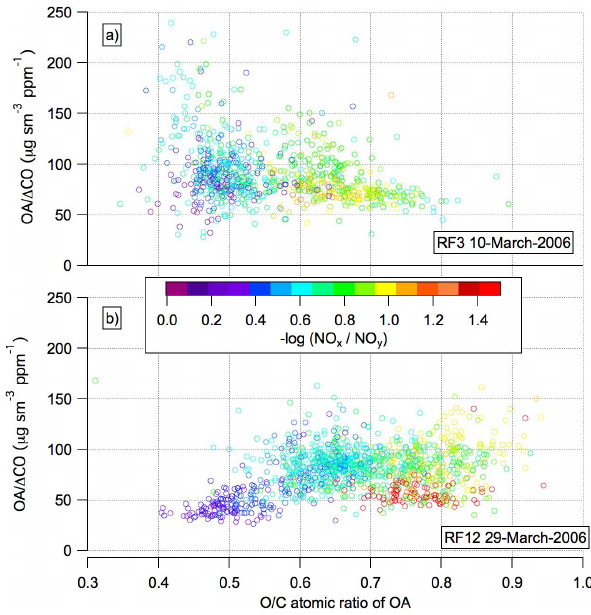
Fig. 2. The OA/ 1 CO ratio vs. the O/C atomic ratio of Organic Aerosol for RF3 (part a) and RF12 (part b). The color of the points is given by –log 10 (NO x /NO y ). The influence of biomass burning is clear in the higher OA/ 1 CO values shown for low O/C ratio in RF3. RF12 shows increasing OA/ 1 CO ratios with photochemical age indicating SOA formation with